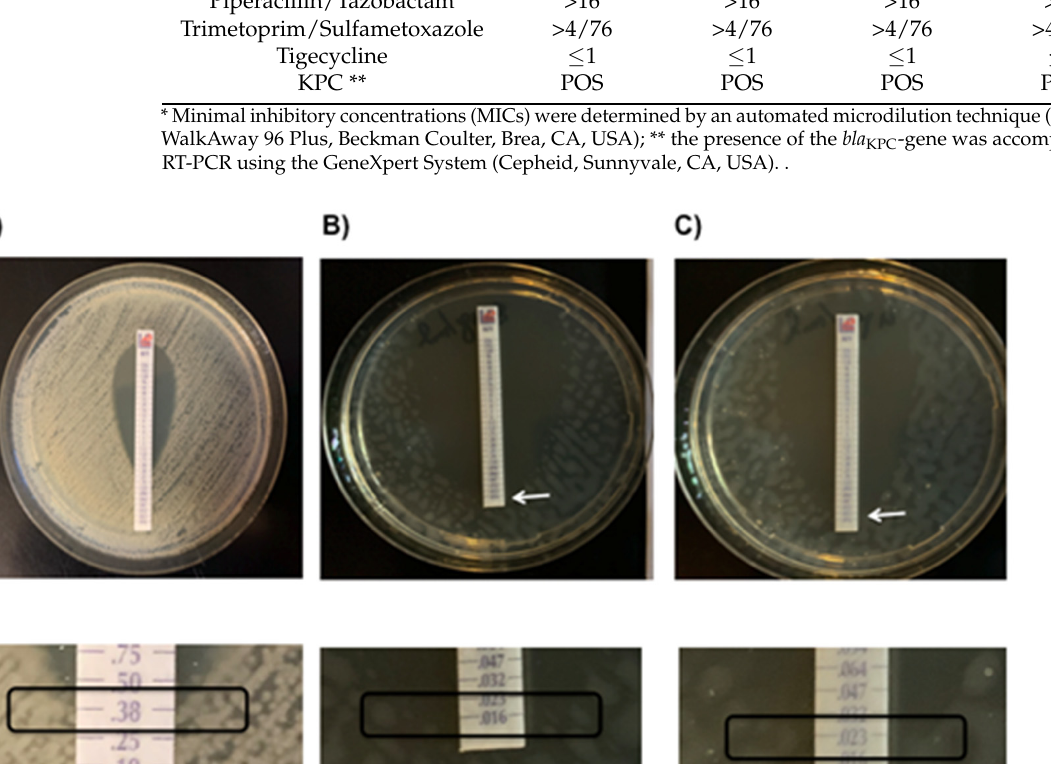
Table 1. Antimicrobial susceptibilities (MIC, µ g/mL *) of serial KPC-Kp blood isolates. Antimicrobial Agent